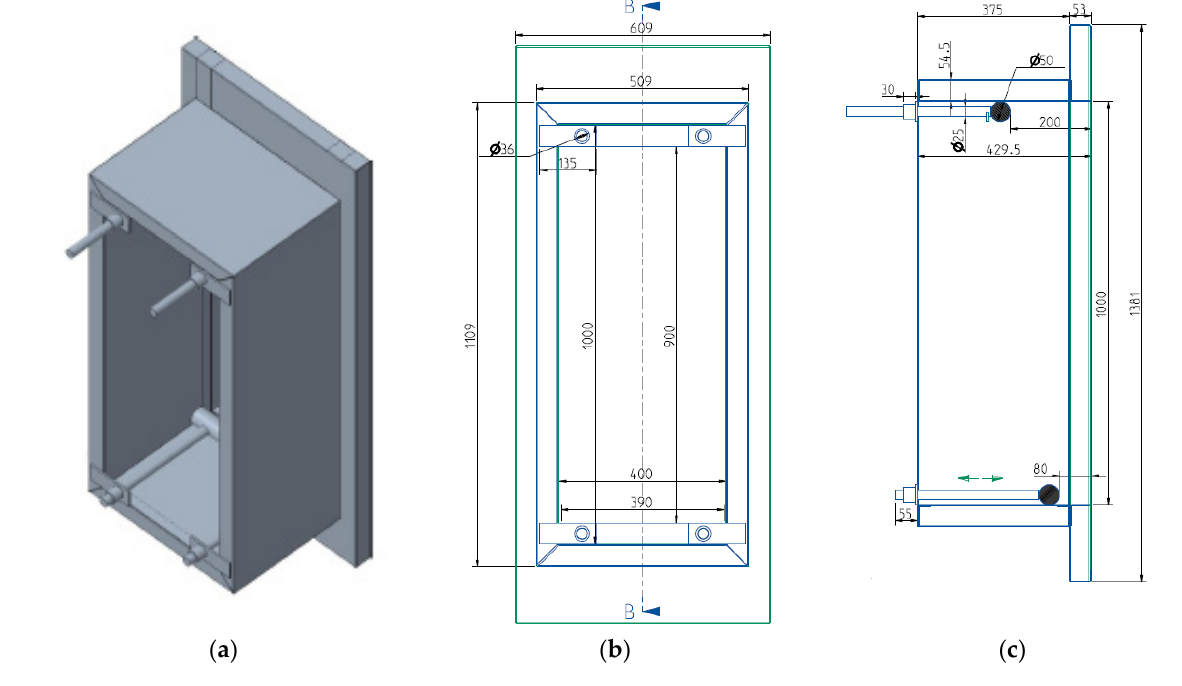
Figure 3. A detailed drawing of the oven door modifications: ( a ) 3D scheme; ( b ) drawing of the door modification (front view); ( c ) drawing of the door modification (side view—section B–B).